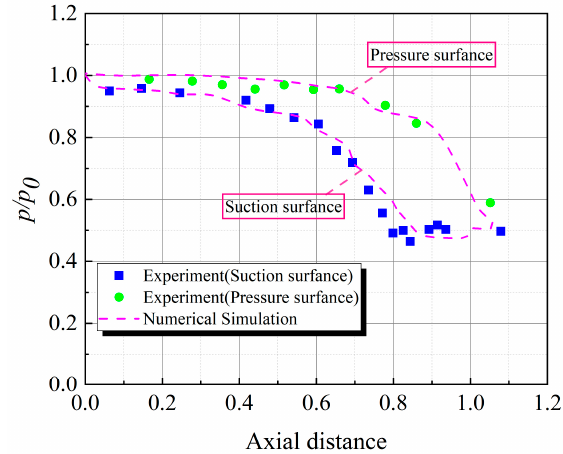
Figure 3. Comparison between numerical simulation results and experimental results.